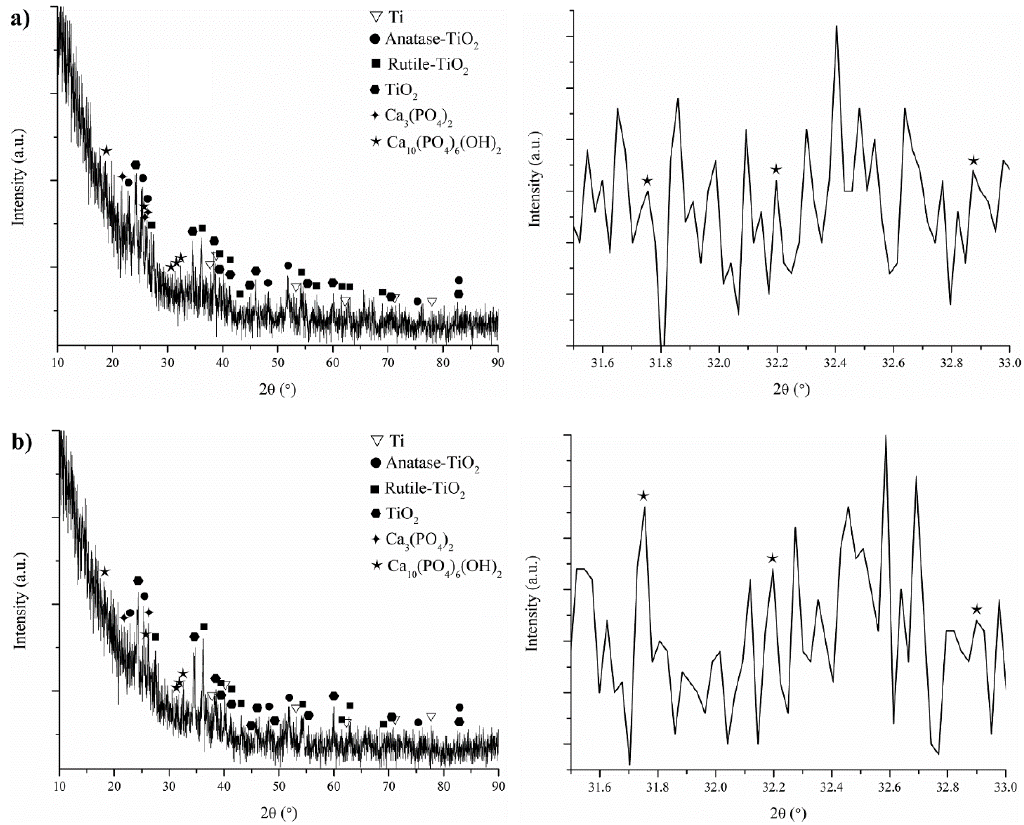
Figure 5. TF-XRD spectra pattern of the coatings at post-immersion in SBF at 36.5 ◦ C for 28 days: ( a ) the MAO coating and ( b ) Cu-based MAO coating.